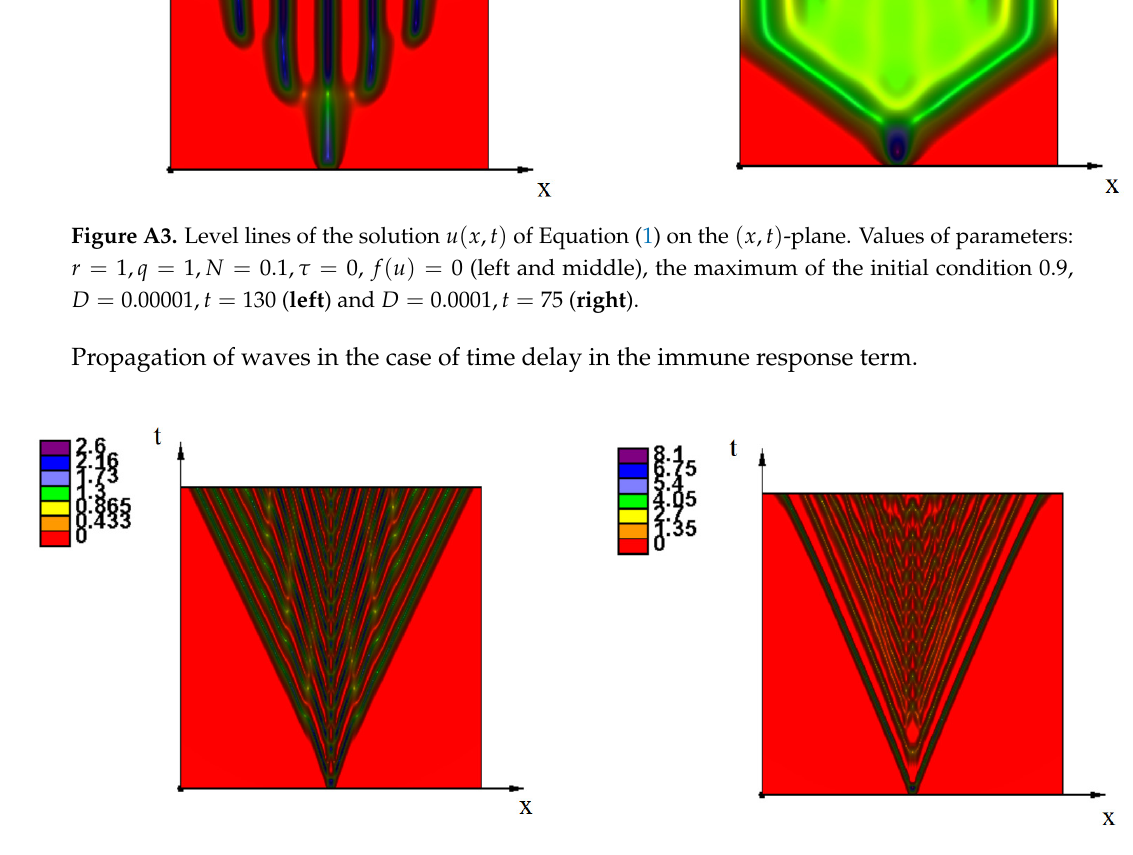
Figure A4. Level lines of the solution u ( x , t ) of Equation (1). The values of parameters: r = 1, q = 1, L = 2, D = 10 − 5 , k 1 = 0.9, τ = 4, N = 0.05 ( left ), N = 0.1 ( right ), t =